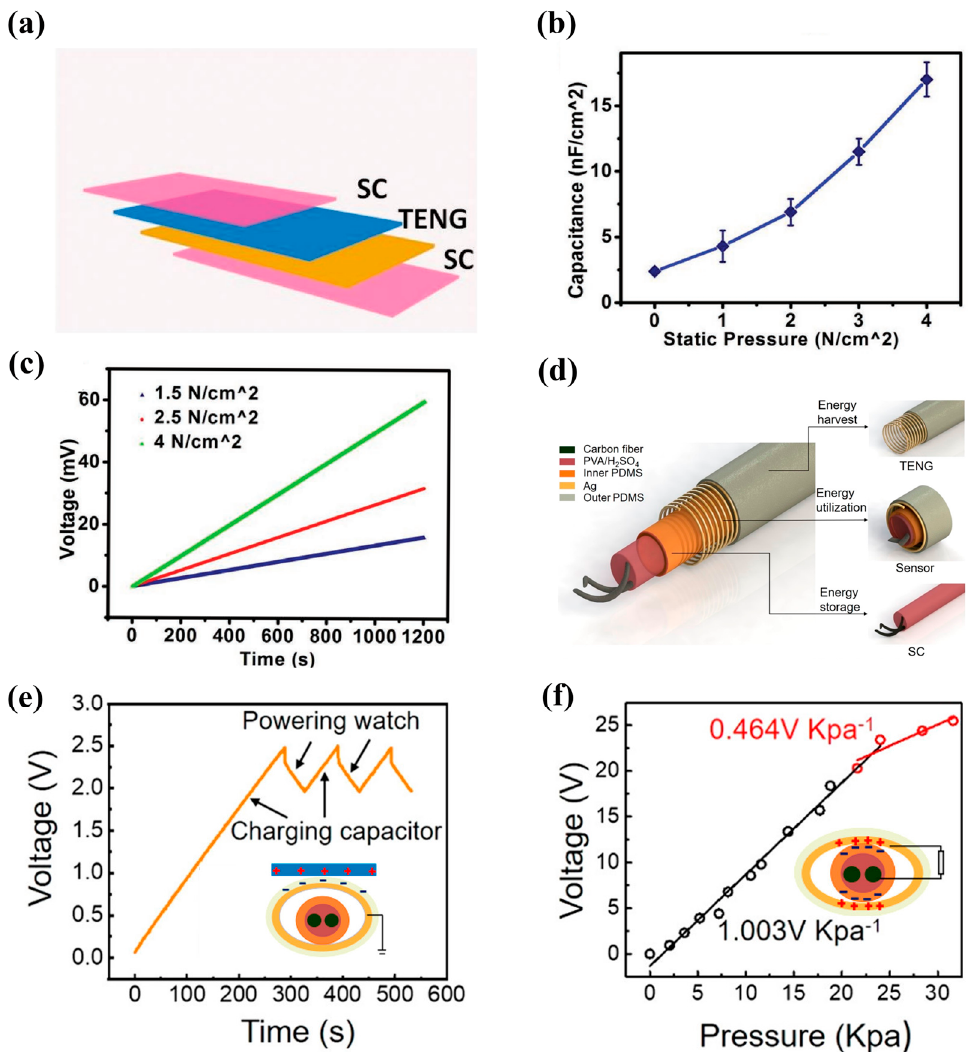
Figure 5. ( a ) Schematic illustration of TSC-based pressure sensor and its ( b ) capacitance–static pressure curve; ( c ) voltage under periodic external force of the same frequency (2 Hz). Reprinted with permission from Ref. [92] Copyright 2018, Advanced Energy Materials. ( d ) Schematic structure diagram of the multifunctional coaxial energy fiber. ( e ) Voltage–time curve of capacitor during charging of the capacitor and powering an electronic watch. Insert is the schematic diagram of single-electrode mode ( f ) Force–voltage curve of the integrated fiber, and the insert shows the contact-separation mode. Reprinted with permission from Ref. [93]. Copyright 2021, ACS nano.